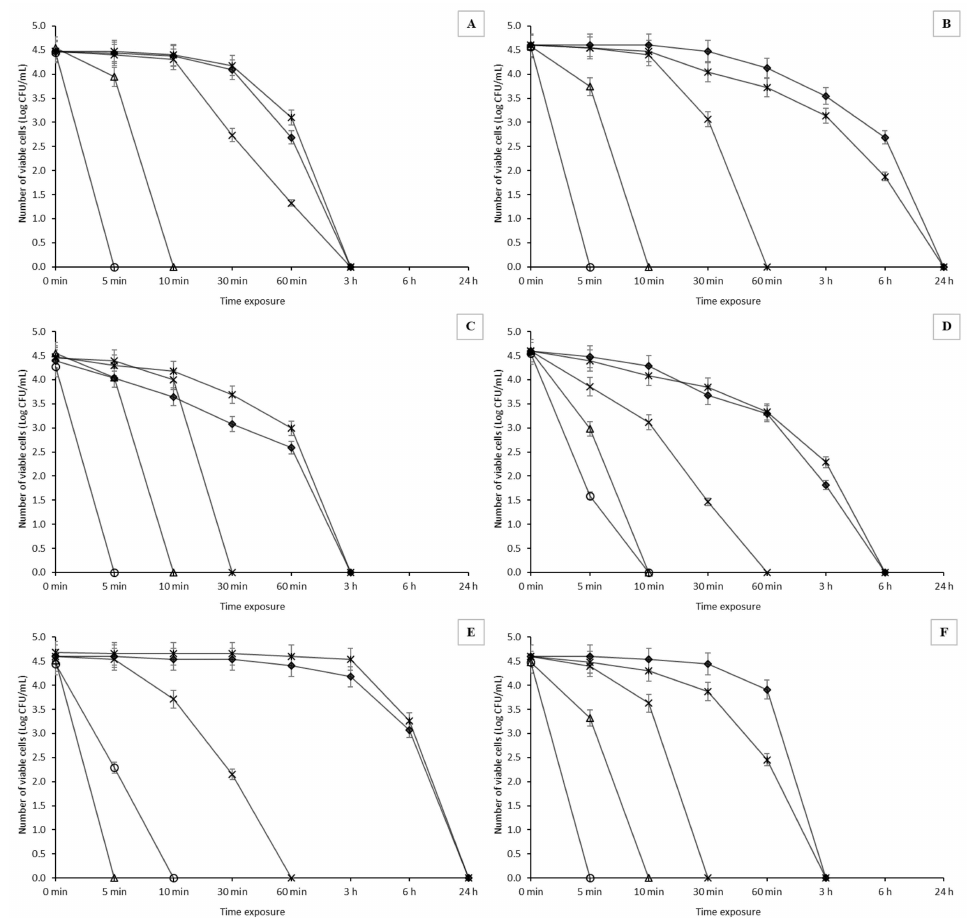
Figure 3. Survival of Arcobacter -like strains in the presence of WEOO at a sample concentration of 90%. Spanish extra-virgin olive oil (circle); Greek extra-virgin olive oil (triangle); blended sun- flower and extra-virgin olive oil (times); pure olive oil (diamond); olive pomace oil (asterisk). ( A )— Aliarcobacter butzleri CCUG 30484; ( B )— Aliarcobacter butzleri UPa 2013/30; ( C )— Aliarcobacter cryaerophilus CCM 7050; ( D )— Aliarcobacter cryaerophilus UPa 2013/13; ( E )— Aliarcobacter lanthieri LMG 28517; ( F )— Aliarcobacter thereius LMG 24488. The results are presented as a mean ± standard deviation. Statistical significance between the groups was assessed by ANOVA at 5%